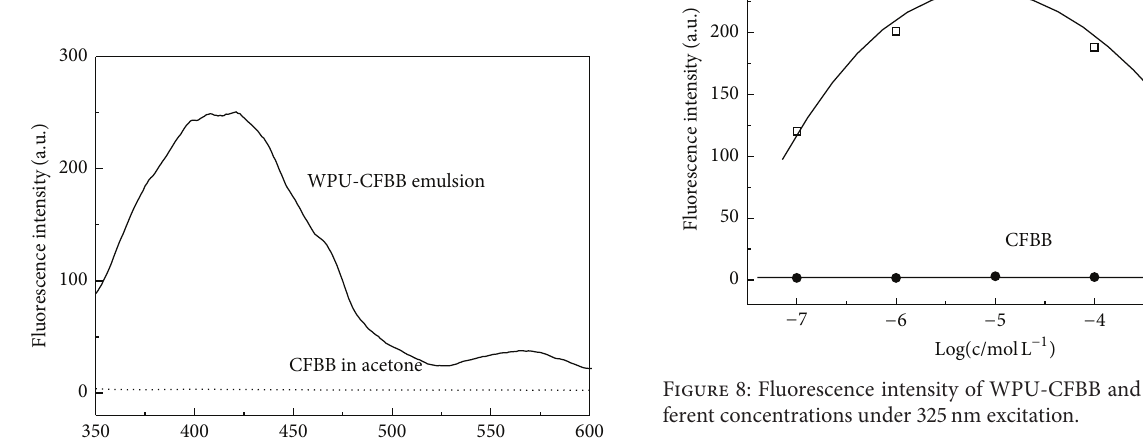
Figure 6: The UV-vis spectra of WPU-CFBB emulsion varying with temperature.